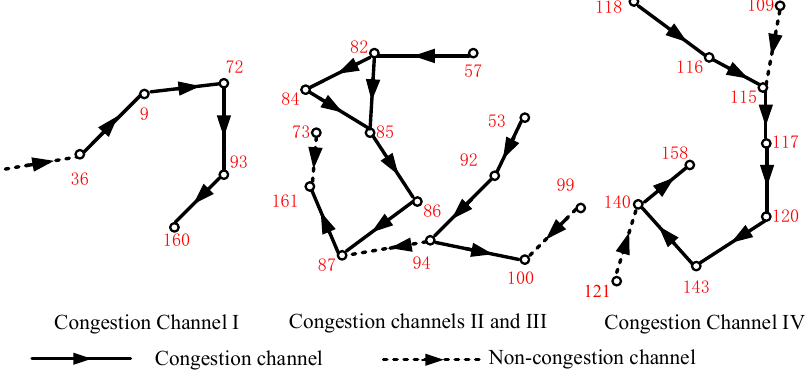
Figure 9. Intermediate power flow congestion channel in Case 2. Table 3. Reactive power adjustment results.